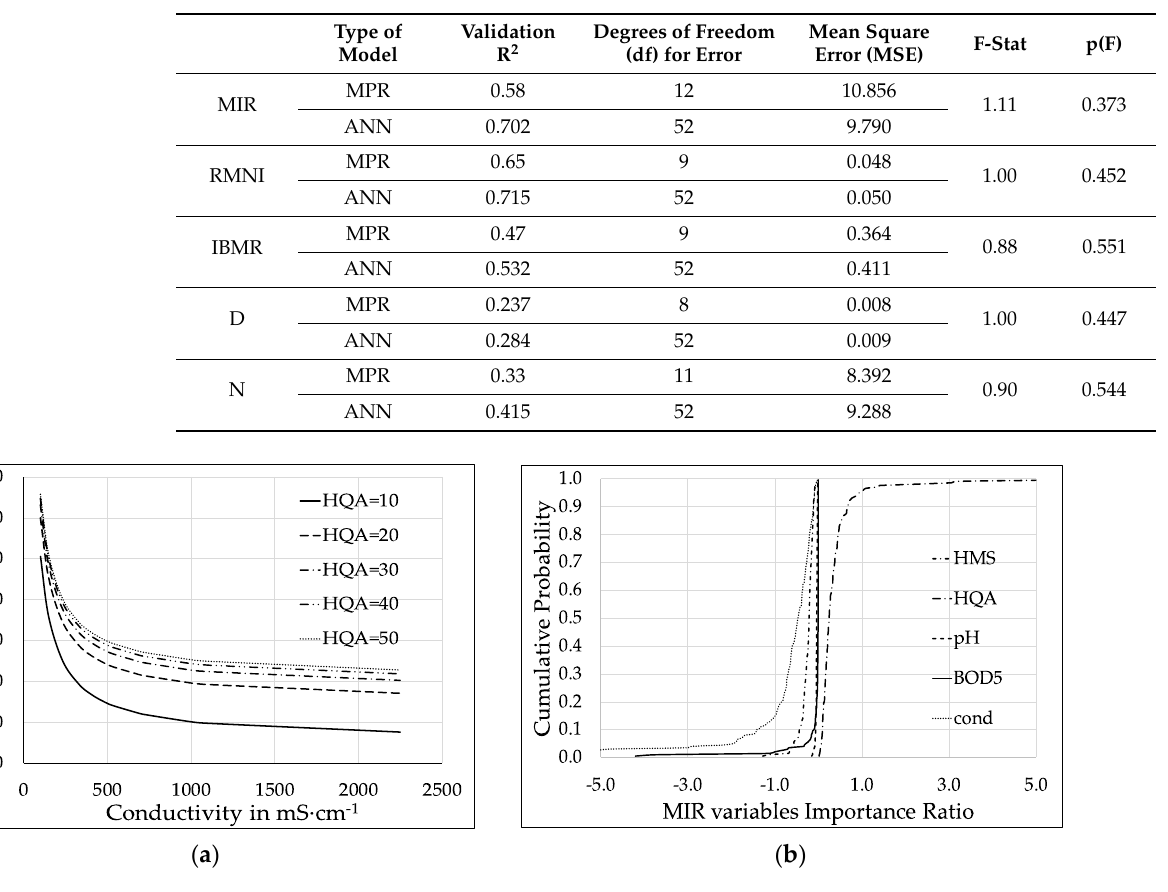
Table 4. Comparing MSE for MPR and ANN models using the F-statistic (ANN data from previous work [18]) Type of Model Validation R 2